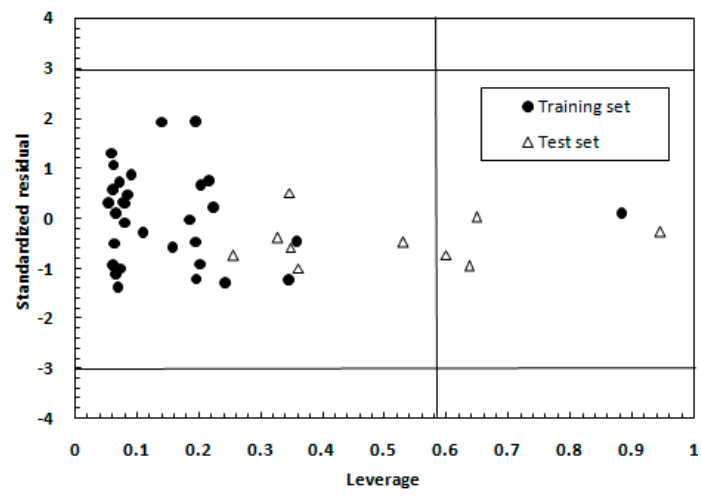
Figure 2. The Williams plot for the MLR model.